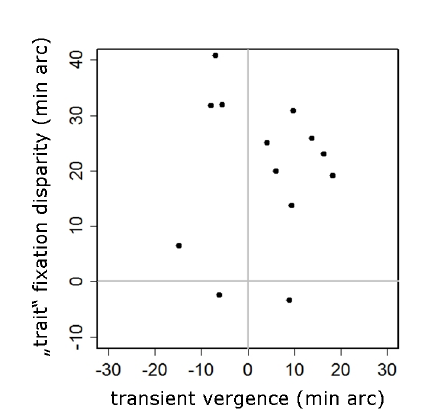
Figure 5: “Trait” fixation disparity (min arc) as a function of average transient vergence during